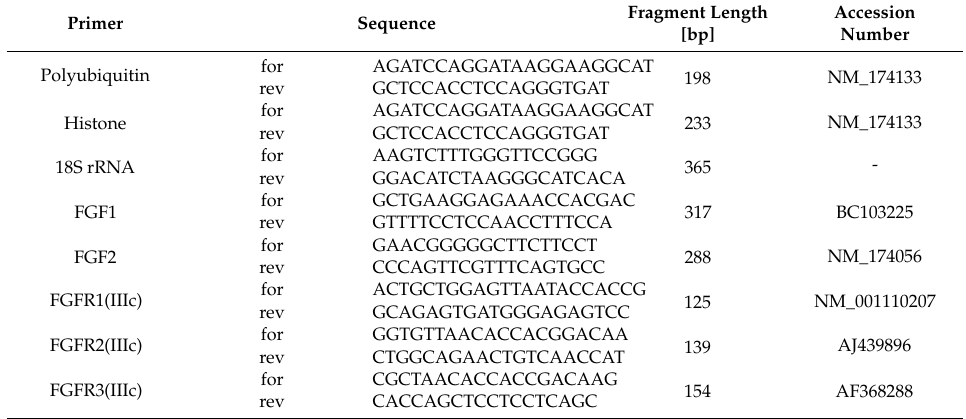
Table 2. Forward (for) and reverse (rev) primer sequences of the reference genes (polyubiquitine, histone and 18S rRNA), the fibroblast growth factor (FGF)-1 and -2 and FGF receptor (FGFR)-1, -2, and -3 isoforms for bovine used in quantitative reverse